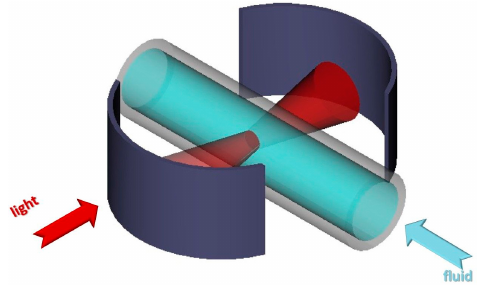
Figure 2. Schematic diagram of the cylindrical Fabry-Pérot cavity with the micro-tube inside.